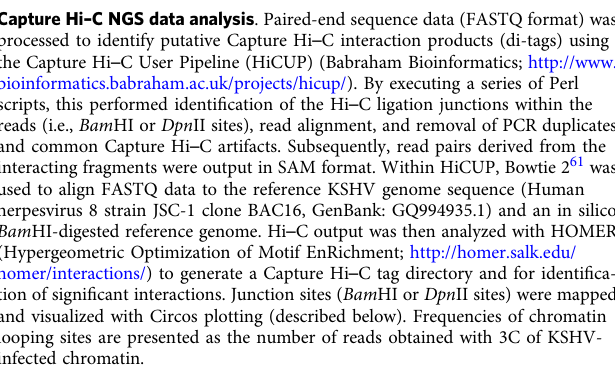
Fig. 8 Proposed model of KSHV ACH. Multiple genomic regions containing K-Rta response elements (REs), including the locate the K-Rta promoter itself as well as other K-Rta responsive promoters, are positioned in close proximity to each other via 3D KSHV genomic structure. This mechanism facilitates K-Rta to activate promoters ef fi ciently. Activation of “ poised ” RNA polymerase II at the K12 and PAN RNA loci then allows traveling to other viral promoters that are brought to in proximity during